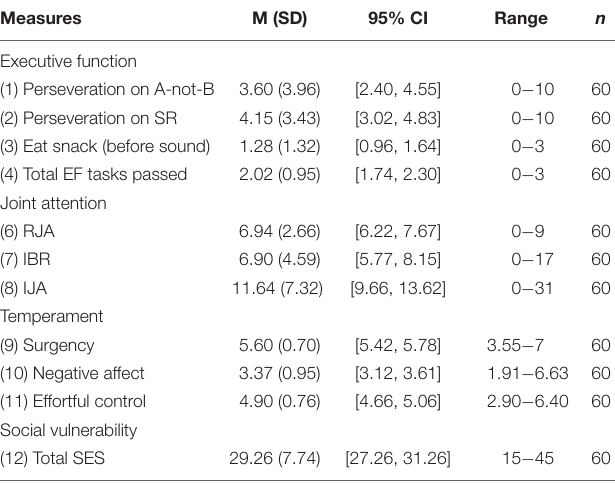
TABLE 2 | Means and standard deviations of measured